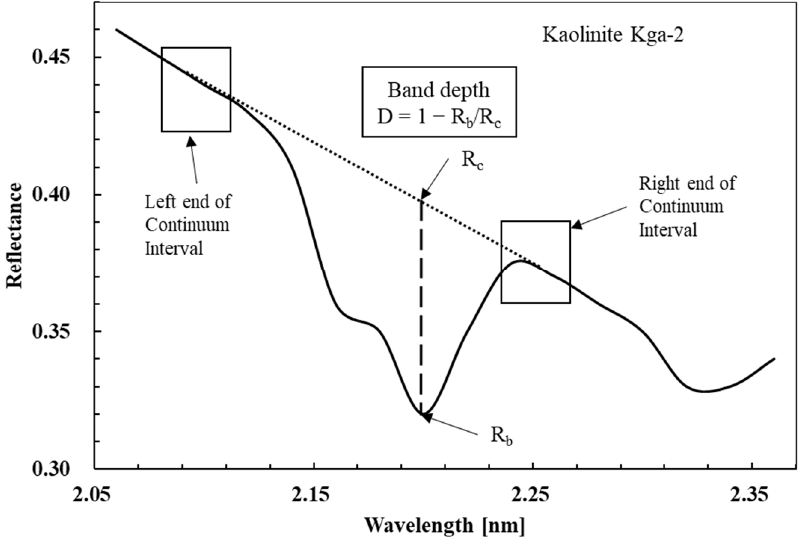
Figure 2. Example showing the characteristics of absorption features. Figure modified from Clark et al. (2003) [51].